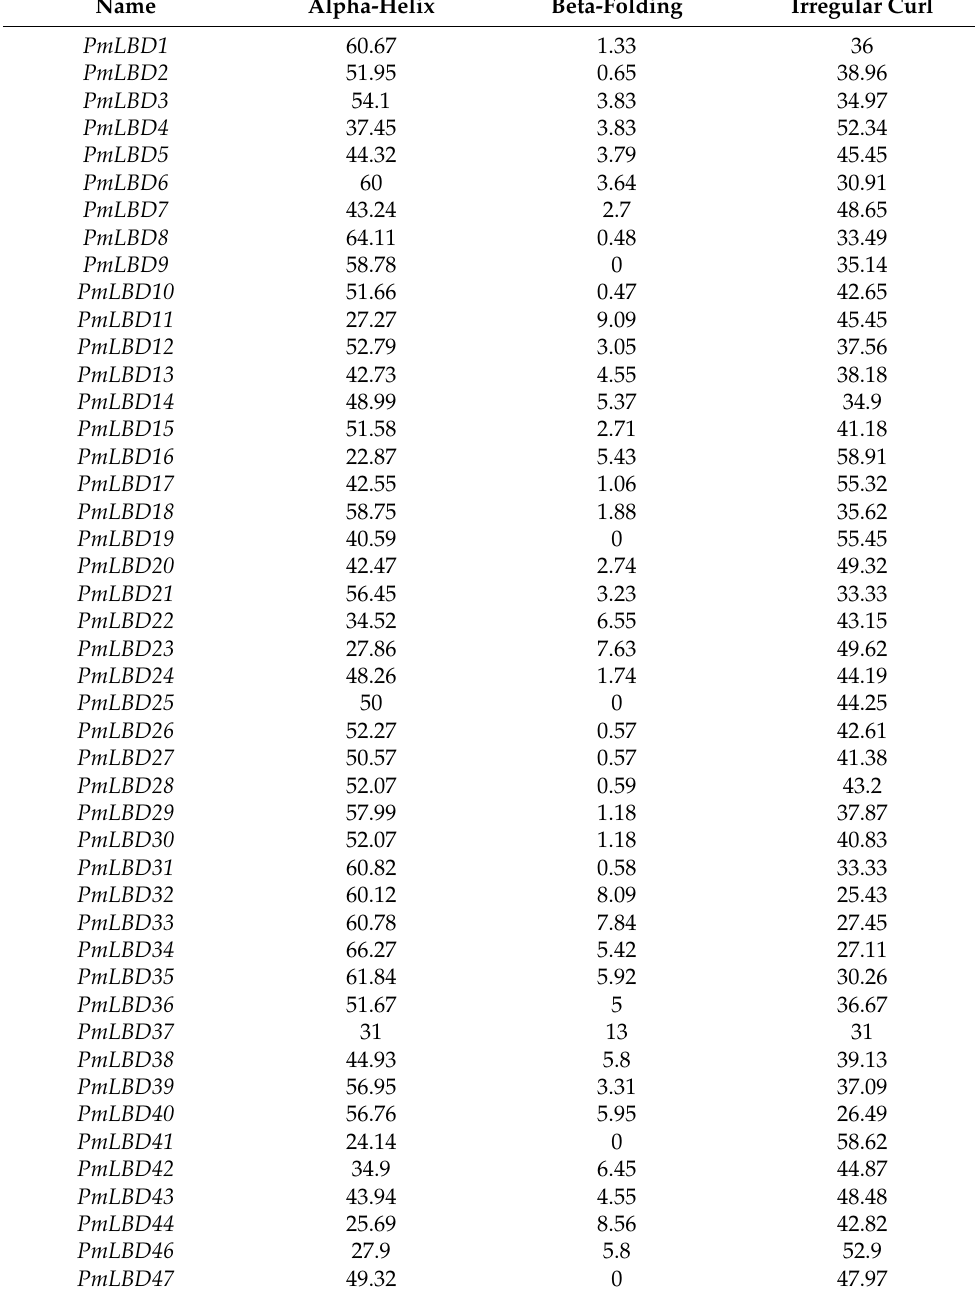
Table 1. Secondary structure analysis of the PmLBD gene